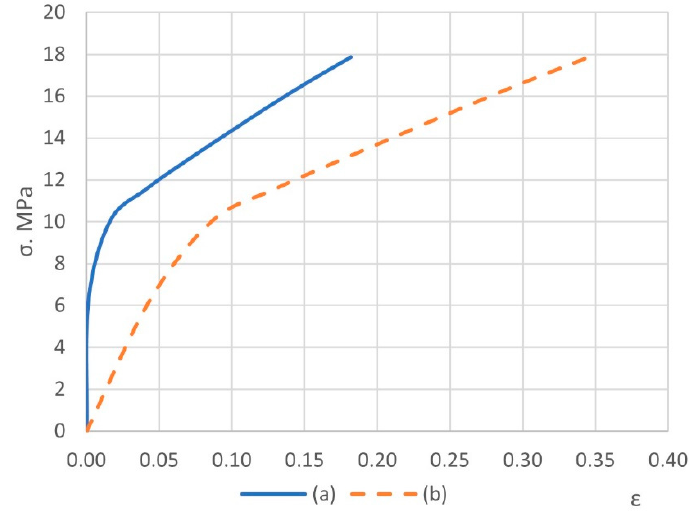
Figure 12. Stress– plastic strain ( a ) and stress– total strain ( b ) curves for composite with spherical filler (first stage).